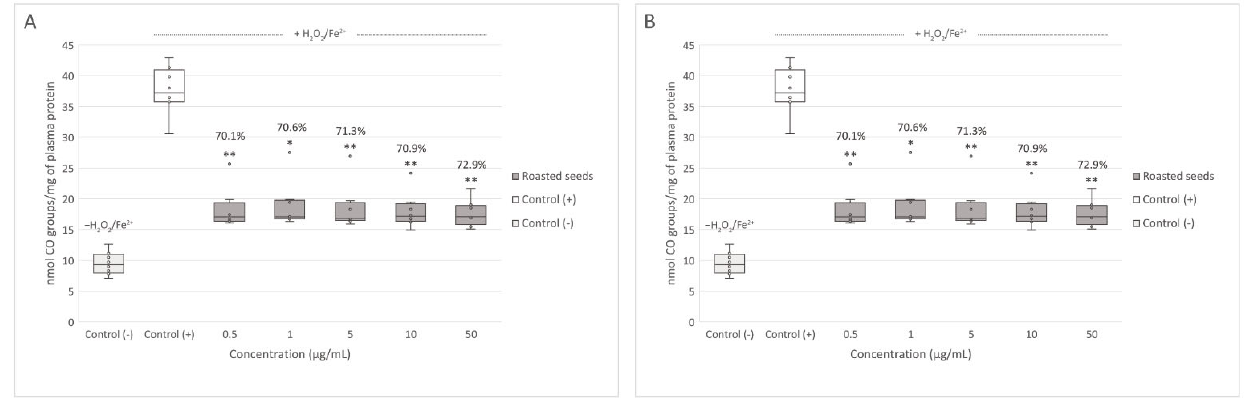
Figure 3. Effect of the extracts from regular ( A ) and roasted ( B ) sea buckthorn seeds (at concentrations 0.5–50 µ g/mL) on the level of carbonyl (CO) groups in human plasma treated with Fe 2+ /H 2 O 2 ( n = 8). Control (+) and test samples (0.5–50 µ g/mL) were incubated (30 min, 37 ◦ C) with Fe 2+ /H 2 O 2 —an oxidative stress inducer. The results are presented as nmol CO groups/mg of plasma protein. The data are expressed as medians and interquartile ranges. The results were considered significant at p < 0.05 (* p < 0.05; ** p < 0,01). The numbers above significant results are % of carbonyl groups oxidation